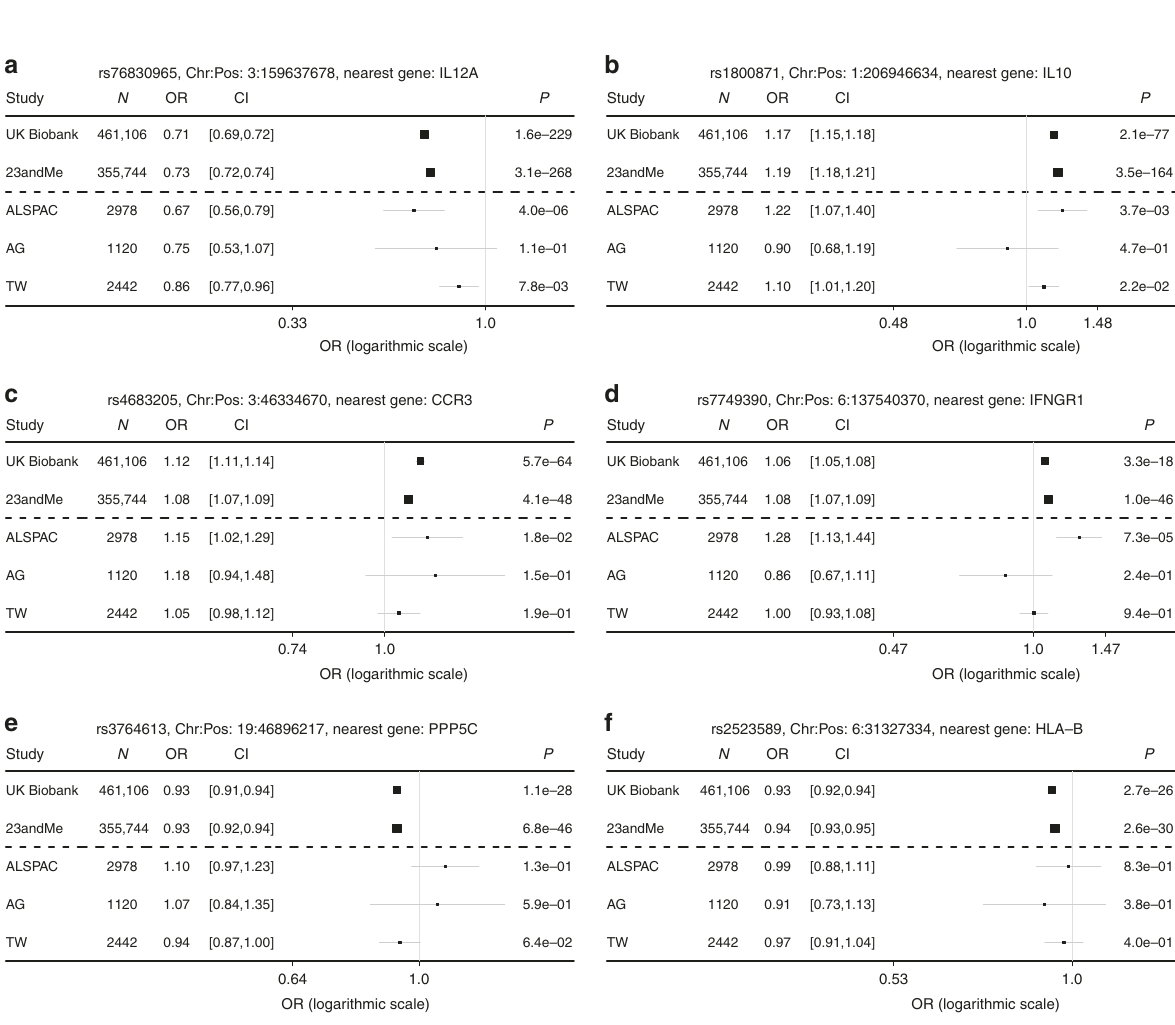
Fig. 2 Forest plot detailing estimates from GWAS, replication and lookup samples for selected variants. Each panel ( a – f ) represents the effect size per allele of the variant on the mouth ulcer phenotype for that study. Estimates are odds ratios and errors bars indicate the 95% con fi dence interval. UK Biobank, ALSPAC and AG = ulcer case control phenotype, TW = severity ulcer phenotype. Chr = Chromosome, Pos = Genomic position (build